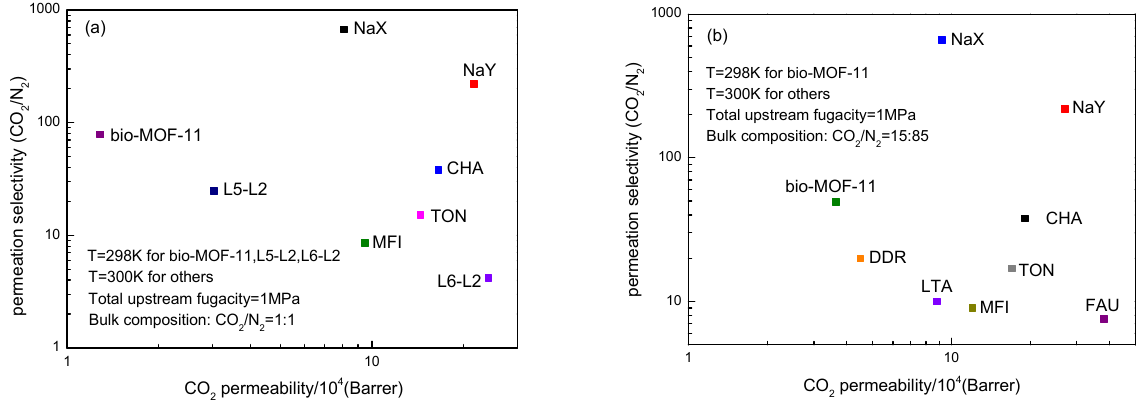
Figure 11. Comparison of permeation selectivity and permeability of MOFs membranes and zeolites for ( a ) 1:1 and ( b ) 15:85 CO 2 /N 2 gas